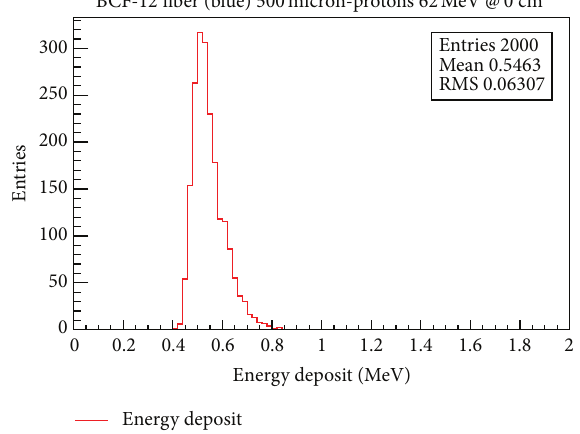
Figure 10: GEANT4 simulation of protons, which pass through the fiber ribbon perpendicularly. Spectrum of energy released by 62 MeV protons on the BCF-12 fibers.